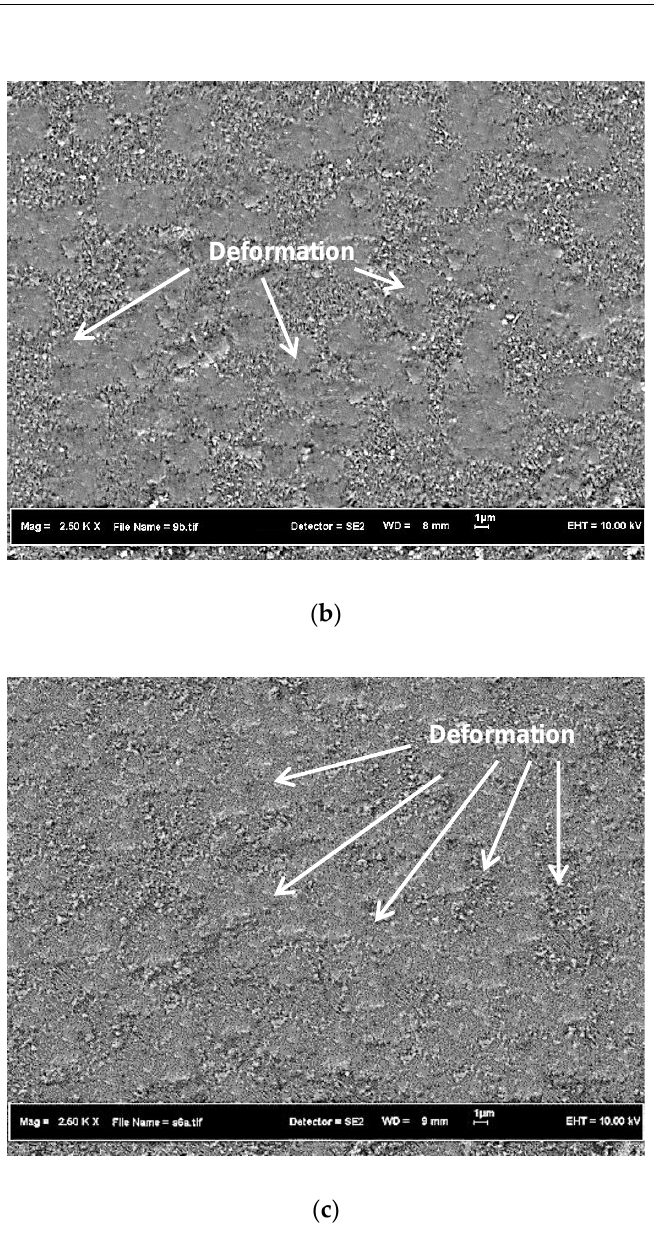
Figure 1. Surface morphology of TiN after ultrasonic treatment at 16 kHz for exposure times of ( a ) 5 min, ( b ) 8 min, and ( c ) 11